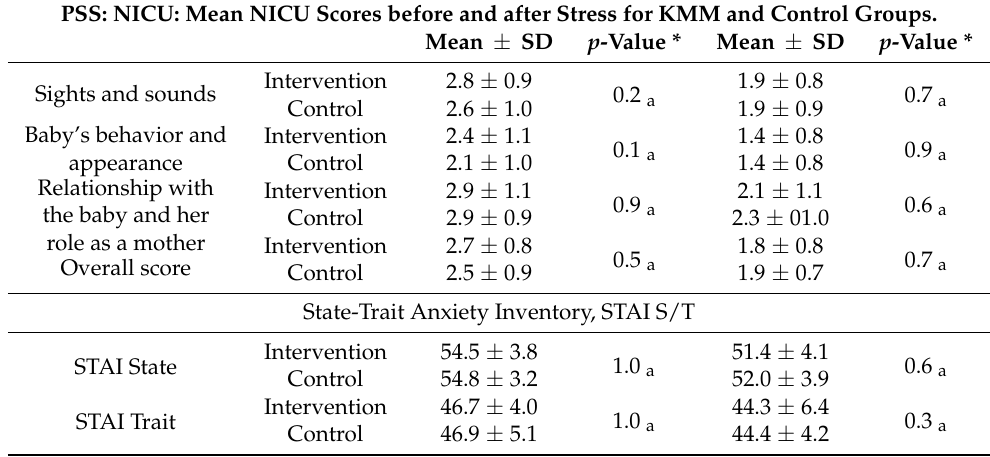
Table 2. Effect of the KMM regarding the questionnaires applied. PSS: NICU: Mean NICU Scores before and after Stress for KMM and Control Groups. Mean ±